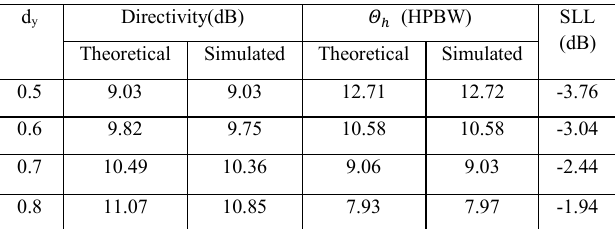
Table 10: Linear antenna array (N = 8 , βy = 0°)